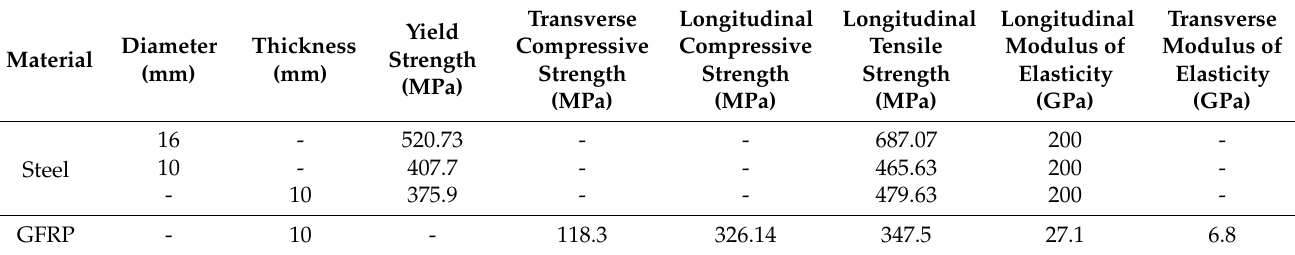
Table 3. Mechanical properties of steel reinforcement and GFRP.